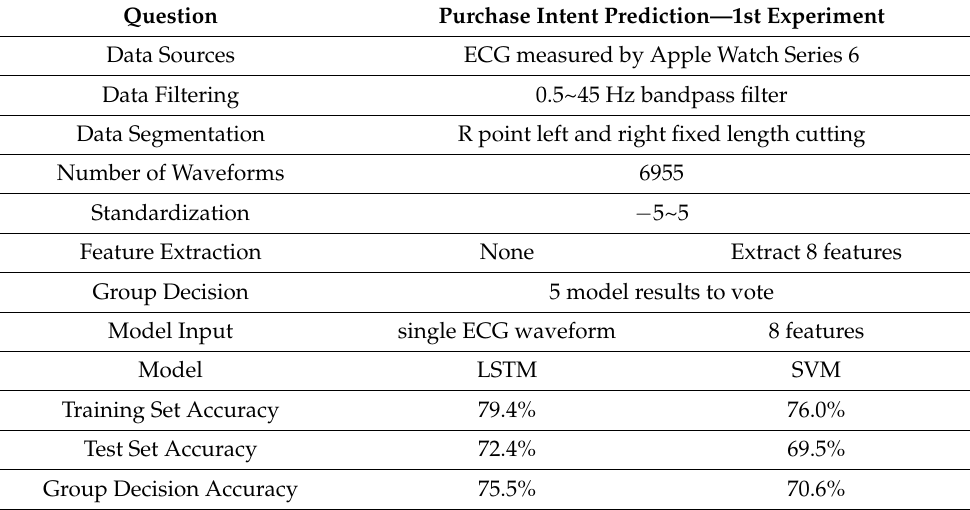
Table 3. Comparison of the experimental results in the first stage.